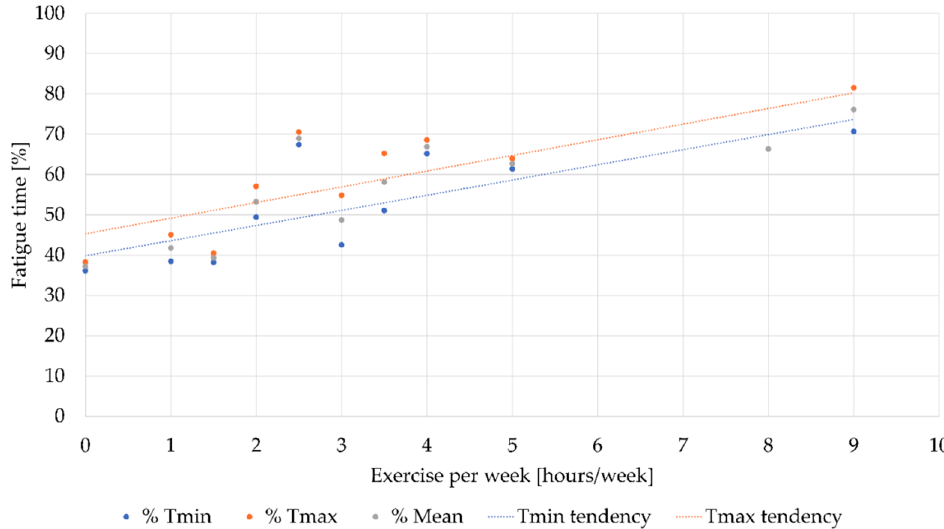
Figure 7. Tendency of the fatigue time versus exercise per week. The results of the experiments were grouped on the basis of the number of hours of weekly exercise in order to evaluate the maximum, minimum and average value. These values are represented in this figure.